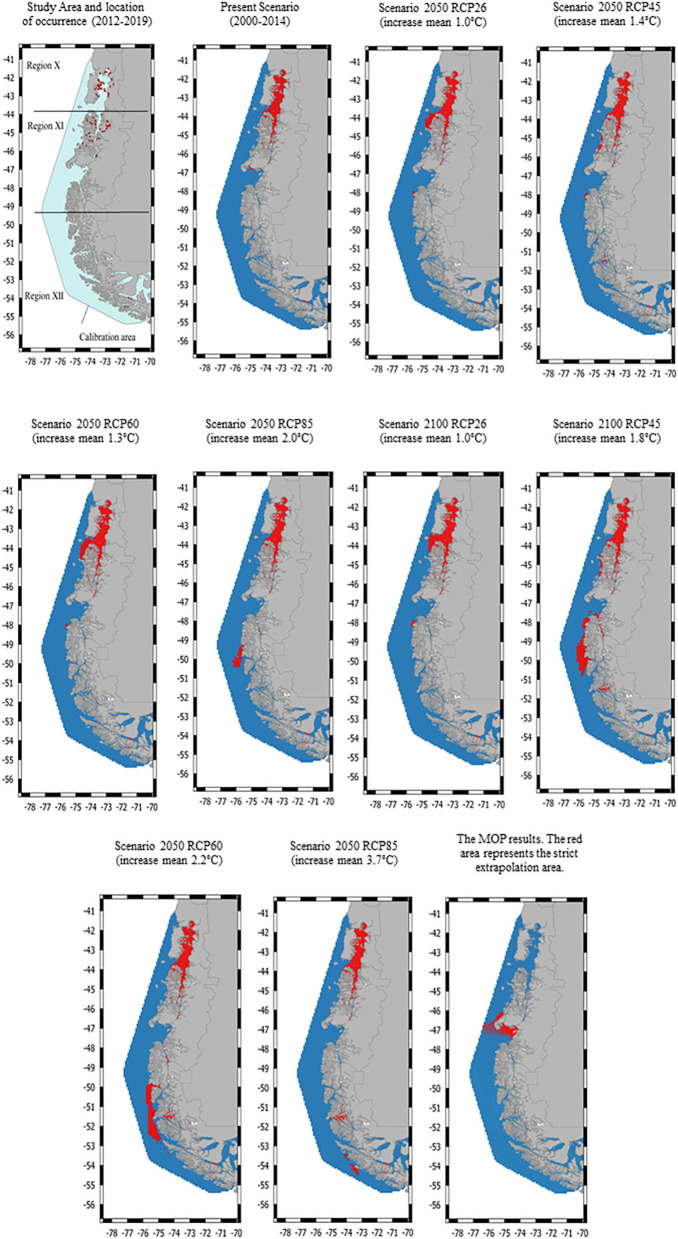
The study area consists of three geographical regions in Chile: region X [Los Lagos], region XI [Aysén], and region XII [Magallanes]. The locations of the Caligus rogercresseyi spatial occurrence used for habitat suitability models are indicated by red dots. Habitat suitability maps for C. rogercresseyi (red areas) in southern Chile at present and two future projections (2,050 and 2,100) under different climate change scenarios using a maximum entropy modeling (Maxent). Different representative concentration pathways (RCP 2.6–8.5) represent different greenhouse gases concentrations.